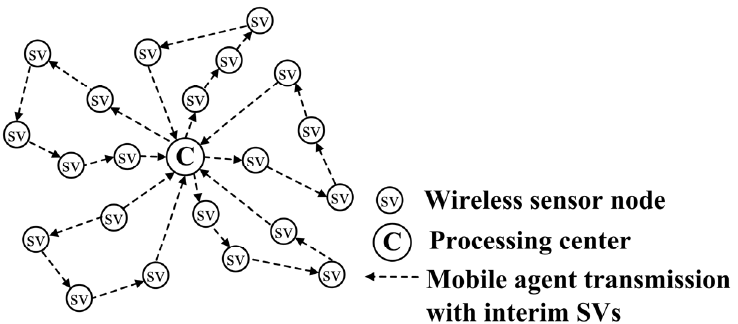
Figure 3 . Computing scenario of MA learning